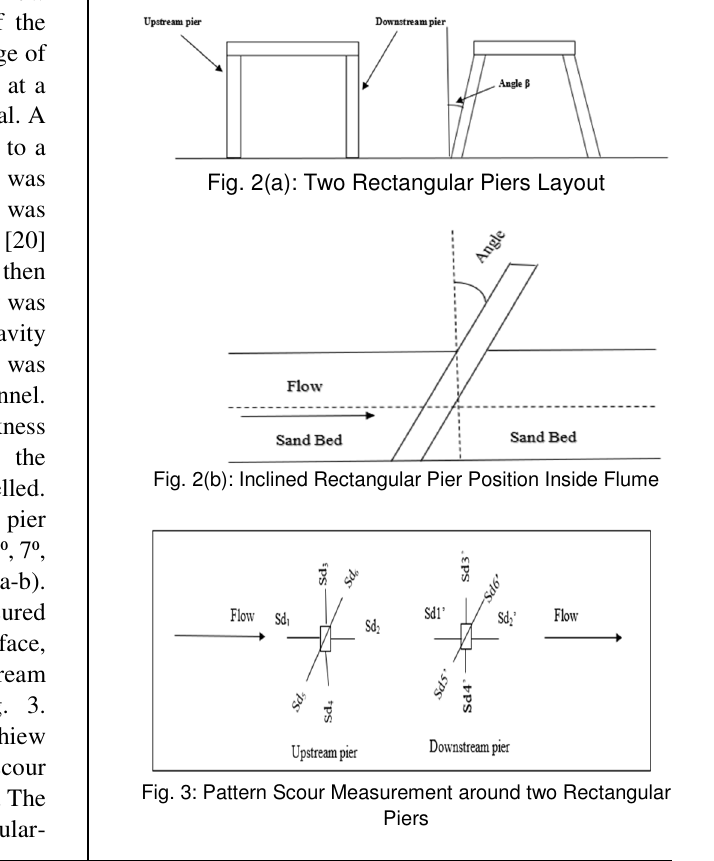
Fig. 2(a): Two Rectangular Piers Layout